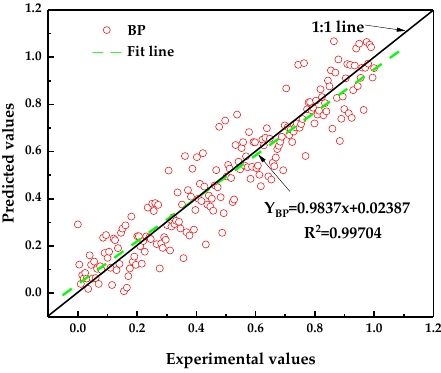
Figure 8. Comparison of training predicted value and experimental value of BP neural network.